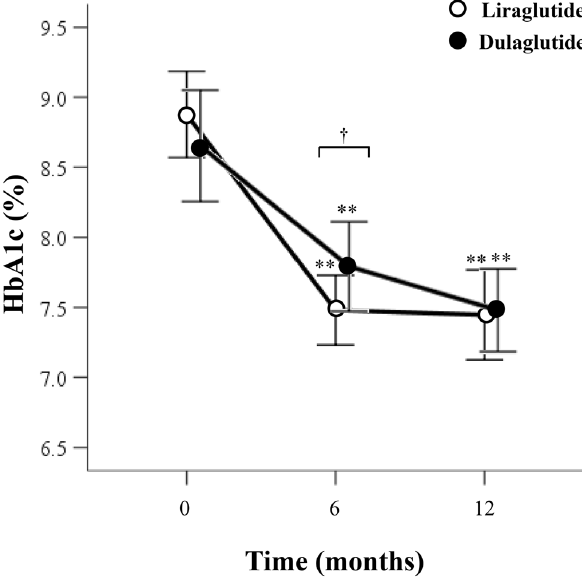
Figure 1. HbAlc levels at baseline and 6 and 12 months of treatment after adjustment by stabilized propensity score-based inverse probability of treatment weighting. Data are mean (95% CI). **P < 0.01 vs . baseline, by Wilcoxon signed-rank test. † P < 0.05 for between the two groups, by Wilcoxon rank-sum test. HbA1c glycated hemoglobin.